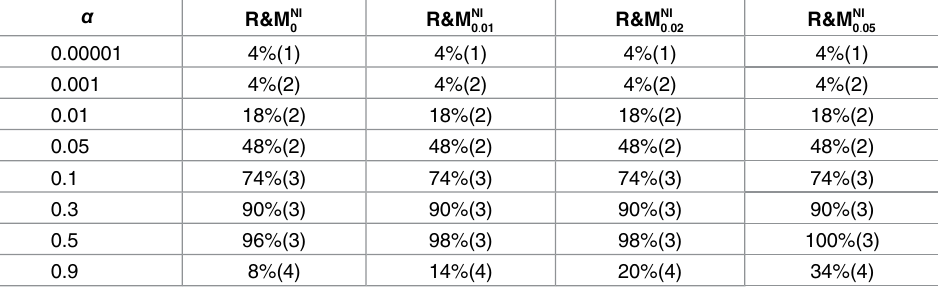
Table 4. The results of Scenario B2. Percentage of data sets in which the true numberof clusters was found, with the mode of the estimated number of classes in parentheses. α R&M NI